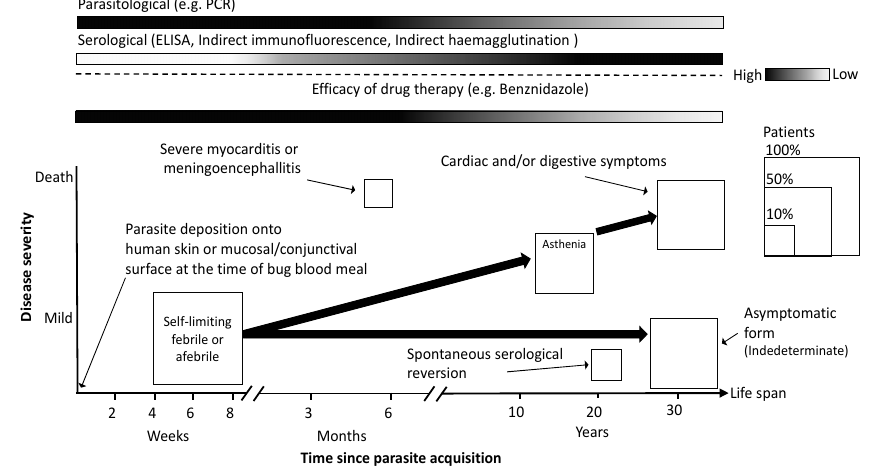
Figure 2. Schematic representation of Chagas disease severity evolution. Disease severity is presented along a time axis beginning with parasite acquisition via vectorial infection (see text for other forms of parasite infection). Big arrows show the condition’s progression from a state to another and the size of boxes represents the proportional frequencies of patients presenting that particular condition. Gradient bars show the likelihood of parasite detection by different test types and the drug treatment efficacy along the time